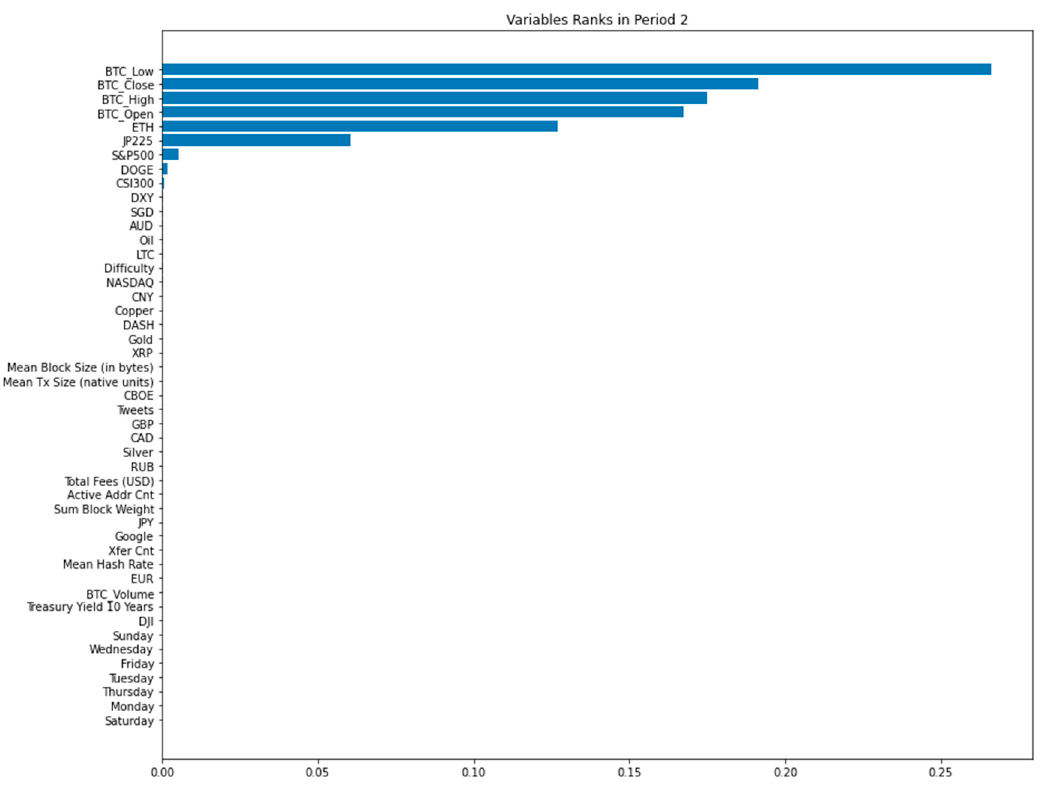
Figure 9. Explanatory variable importance ranks using random forest regression.